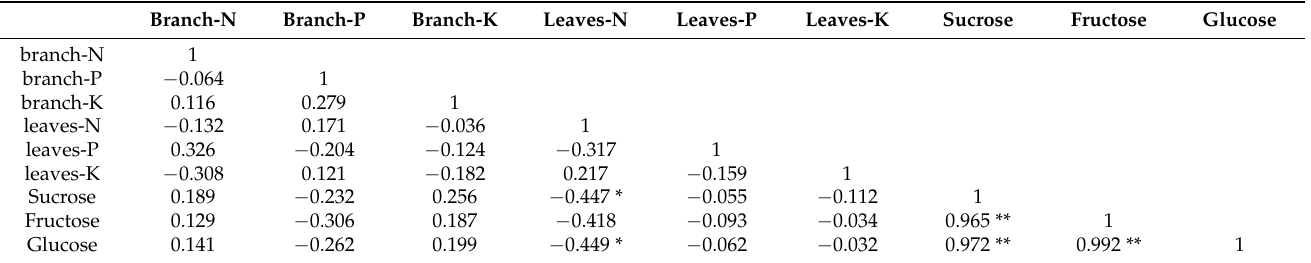
Table 3. Pearson correlation coefficient matrix of NPK content in branches and leaves and fruit soluble sugar content under different fruit load treatments.